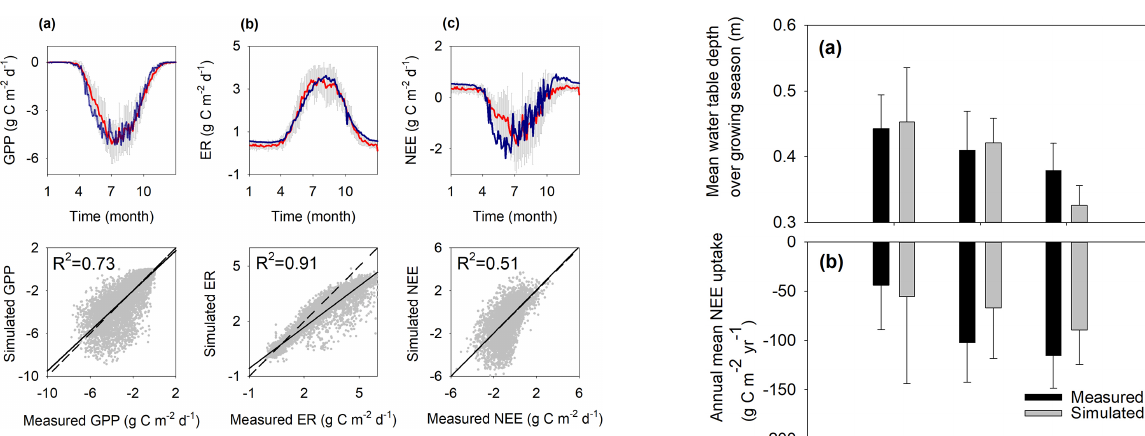
Figure 4. Mean annual seasonal cycle of simulated (blue line) and measured (red line ± standard deviation as grey) ecosystem CO 2 fluxes, and scatter plots of simulated versus measured fluxes: (a) gross primary production (GPP), (b) ecosystem respiration (ER), and (c) net ecosystem exchange (NEE) (1998–2018). Linear least-squares regressions (black lines) are fitted to the daily data. The 1 : 1 relationship is shown as a faint dotted line. R 2 denotes the coefficient of determination.